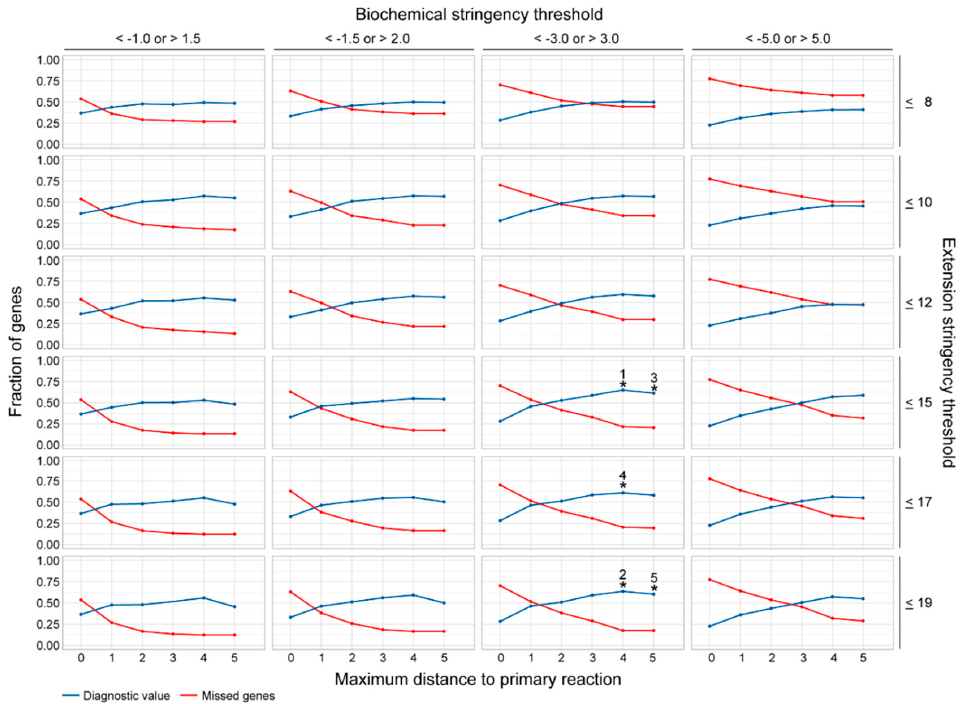
Figure 2. Assessment of the most favorable parameter combination for the cross-omics method. The diagnostic value of the cross-omics method for the different parameter combinations is depicted in blue, the fraction of missed disease-causing genes is depicted in red. The five parameter combinations reaching the highest diagnostic value are highlighted with numbered asterisks: 1: 0.65; 2: 0.64; 3: 0.61; 4: 0.61; 5: 0.60).